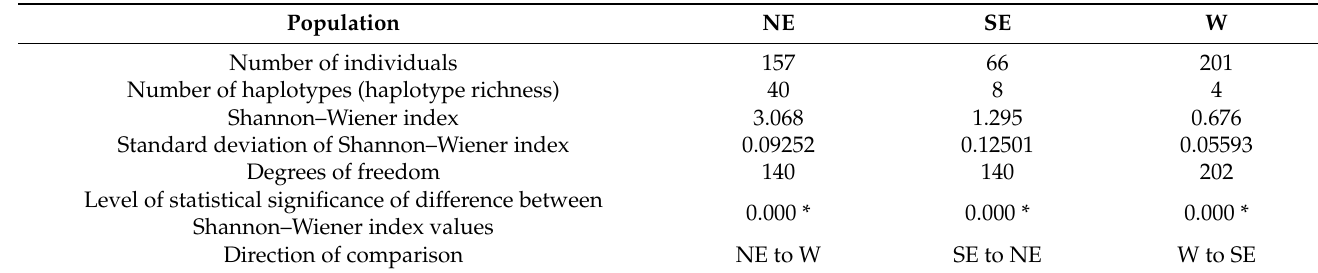
Table 2. Comparison of the haplotype richness of three remaining populations of European mink.